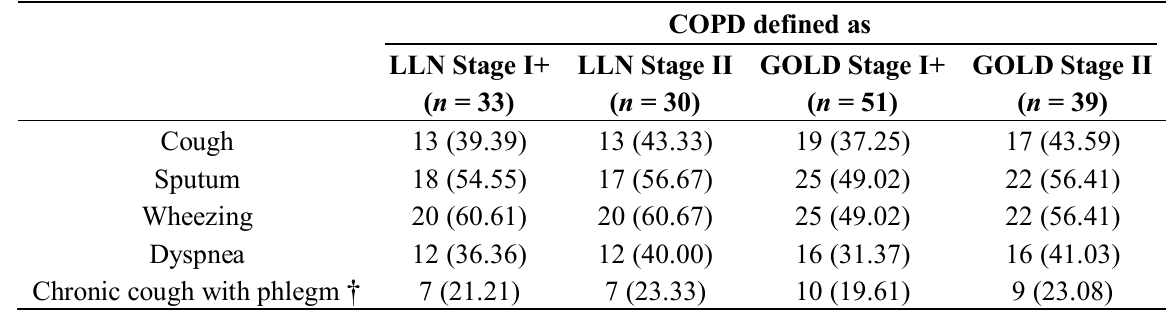
Table 5. Frequencies of respiratory symptoms in patients with chronic obstructive pulmonary